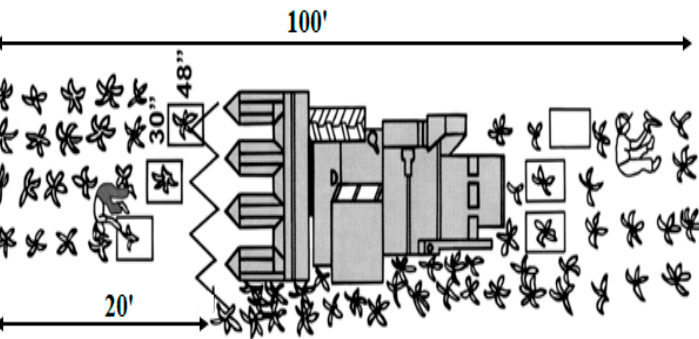
Figure 9. Measurement of grain loss by backing up 20 feet in a 10 square foot frame [39].